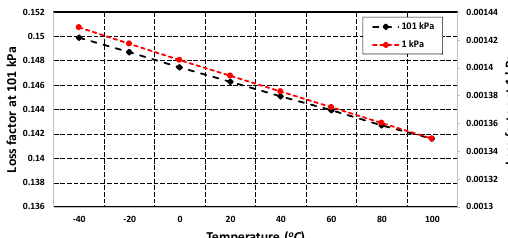
Figure 12. Energy loss factor for MEMS gyroscope with varying operating temperature and pressure values.